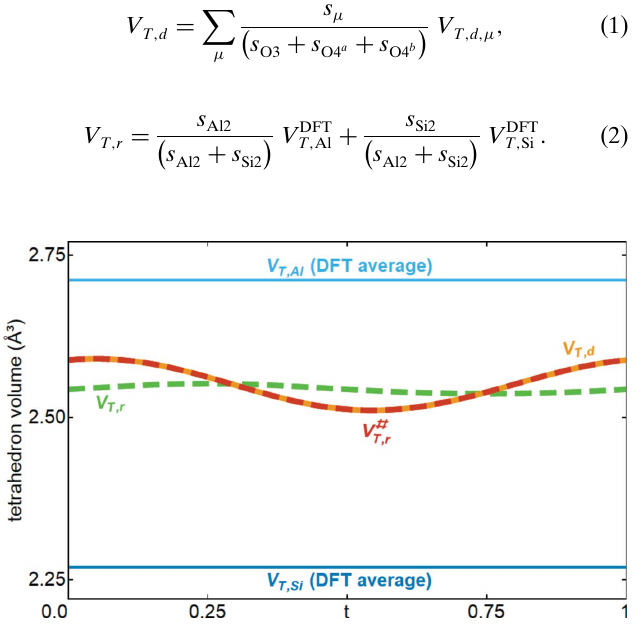
Figure 6 Modulation of the volume of the tetrahedral T site. V T , d ( t ) is the volume calculated using equation (1) from the modulated coordinates of the relevant oxygen atoms. V T , r ( t ) is calculated using equation (2). The discrepancy indicates that the initial occupational modulation functions Figure 7 of Al2 and Si2 are not in agreement with the observed variation of V T , d ( t ). Corrected modulation functions were calculated using equation (3) so Occupational modulation of Al2 and Si2 from the constrained refinement ð t Þ and observed volume V that the expected volume V # (dashed lines) and from the functions derived from V T , d ( t ). The sum is the T , d ( t ) of the T ; r tetrahedron are consistent. same in both cases (green/black